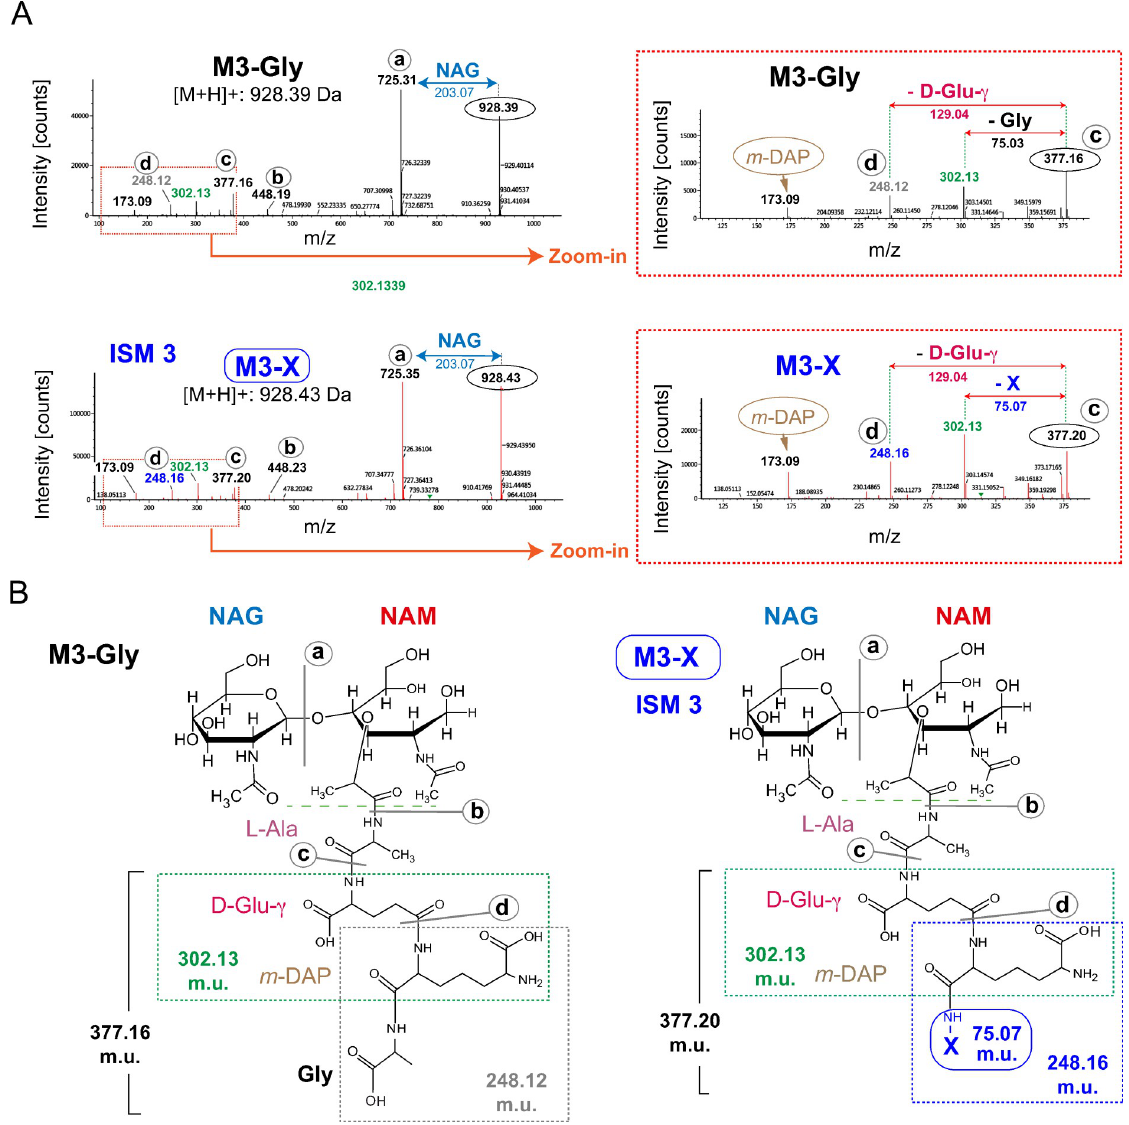
Fig 4. Structure proposed for the muropeptide M3-X identified in the PG of intracellular S . Typhimurium. (A) MS/MS fragmentation spectra of ISM 3 (M3-X). For a detailed analysis of the fragmentation pattern, the MS/MS spectra of the molecule of interest were compared with the one obtained from the previously characterized M3-Gly (a muropeptide presenting Gly instead of D-Ala at the fourth terminal position of the stem peptide). Note the ~0.04 Da difference corresponding the C-terminal residue of the stem tetrapeptide. (B) Chemical structure of the two